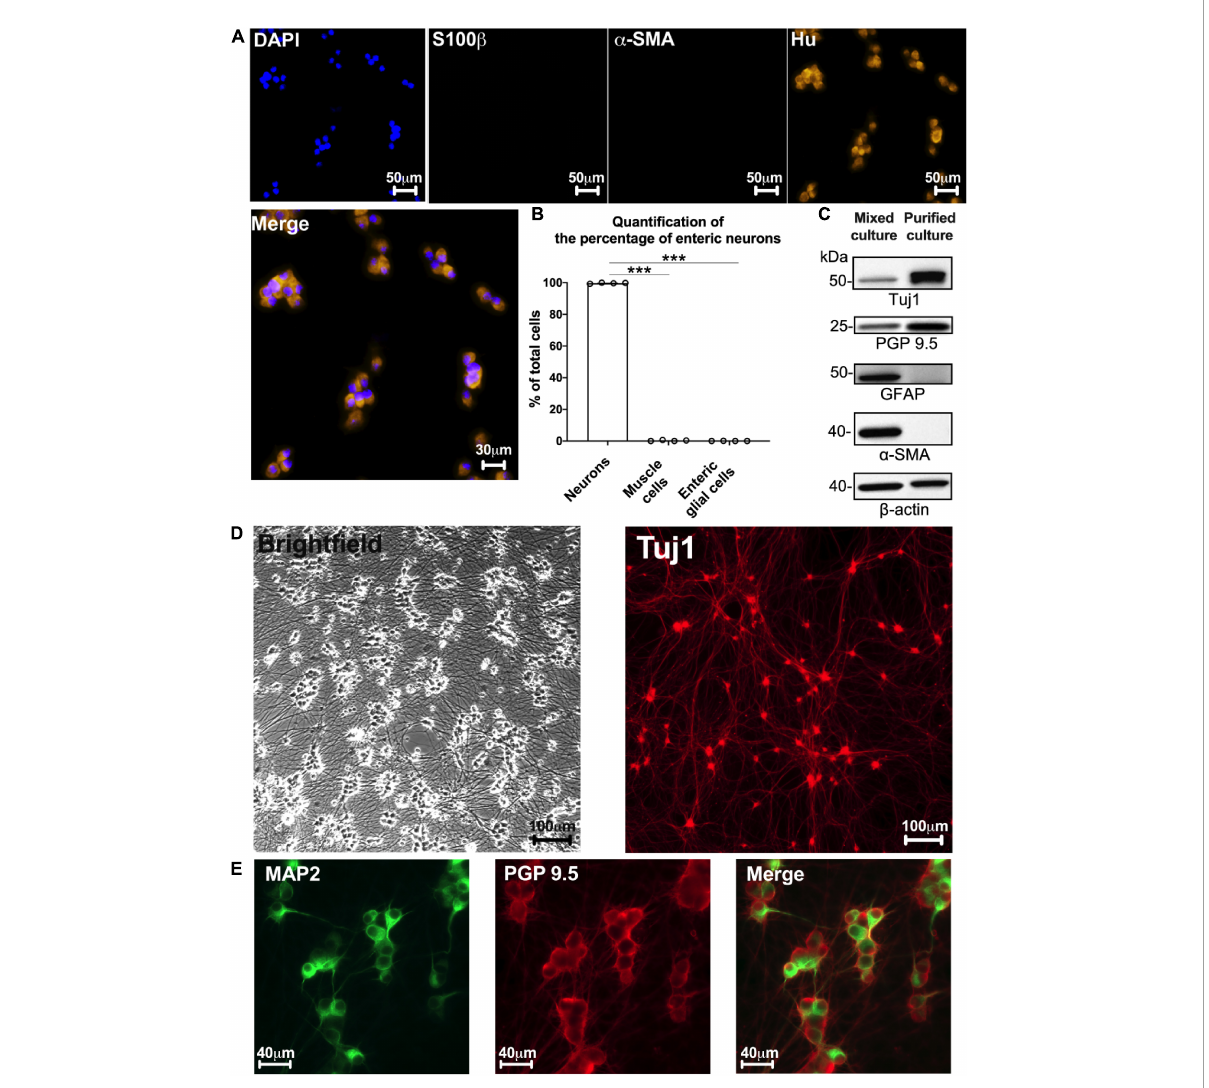
FIGURE2 Highly pure culture of rat enteric neurons. (A) Staining for cell nucleus (DAPI) and immunostaining for enteric neurons (Hu), glial cells (S100b), and myofibroblasts ( α -SMA) at D7 culture. (B) Quantification of the percentage of enteric neurons, glial cells and myofibroblasts in cultures at D7 (Data are presented as mean ± SEM from 644 neurons analyzed from n = 4 culture wells from 4 independent rat embryos). (C) Representative western blot from ENS mixed cell culture (muscle, glia, and neuronal cells) and highly pure culture of enteric neurons ( n = 4 culture wells from 4 independent rat embryos). (D) Brightfield and immunostaining for TUJ1 in culture at D7. (E) Double immunostaining of enteric neurons at D7 with the somatodendritic marker MAP2 (green) and PGP 9.5 (red) ( n = 3 culture wells from 3 independent rat embryos). Results were compared using one-way ANOVA and post-hoc Tukey’s test (*** p <